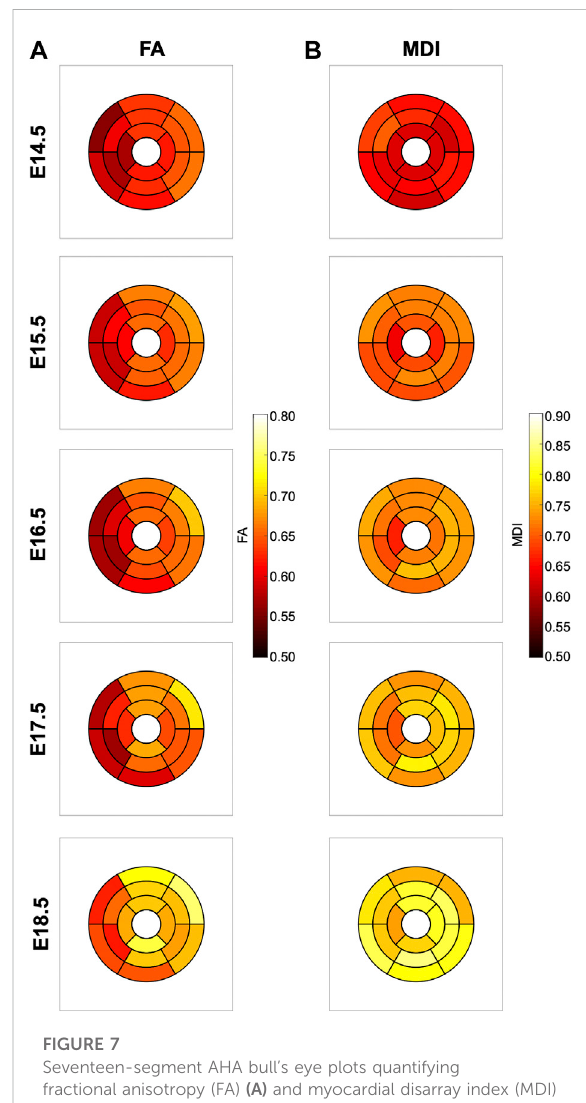
FIGURE 7 Seventeen-segment AHA bull ’ s eye plots quantifying fractional anisotropy (FA) (A) and myocardial disarray index (MDI) (B) in developing murine hearts at E14.5, E15.5, E16.5, E17.5 and E18.5 days of